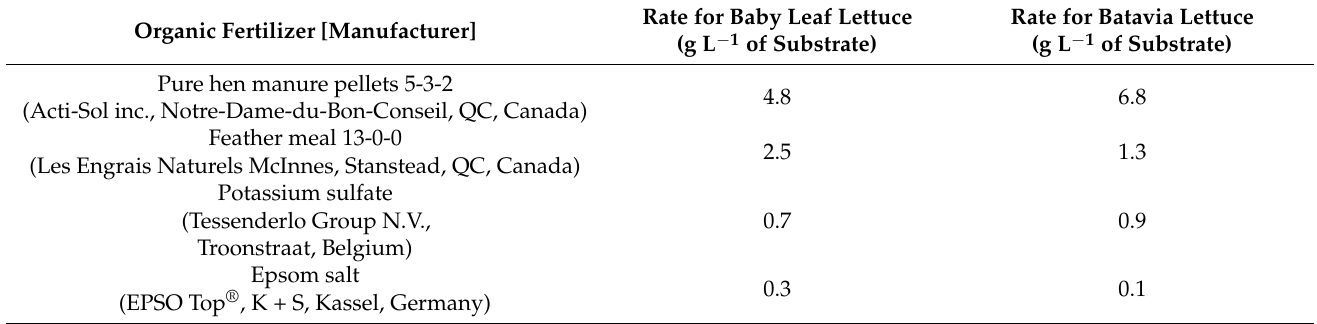
Table 1. Organic fertilizers used for the organic growing system trials.